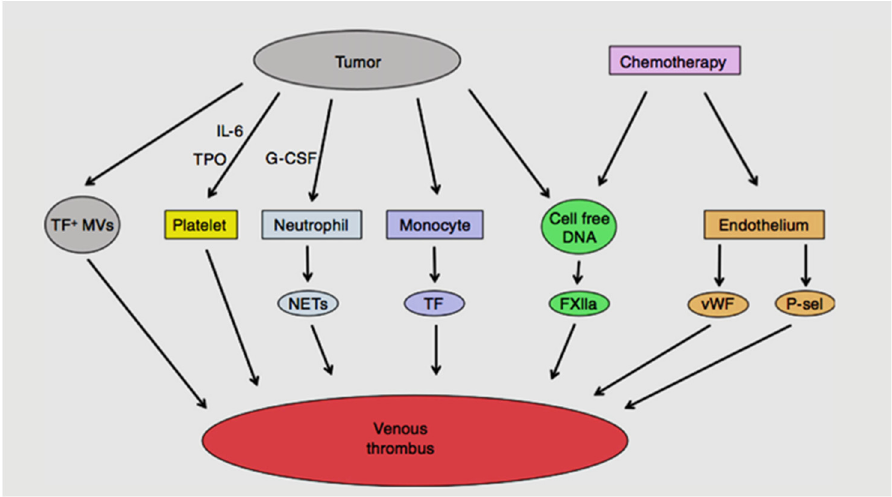
Figure 1. Mechanisms of cancer-associated thrombosis.